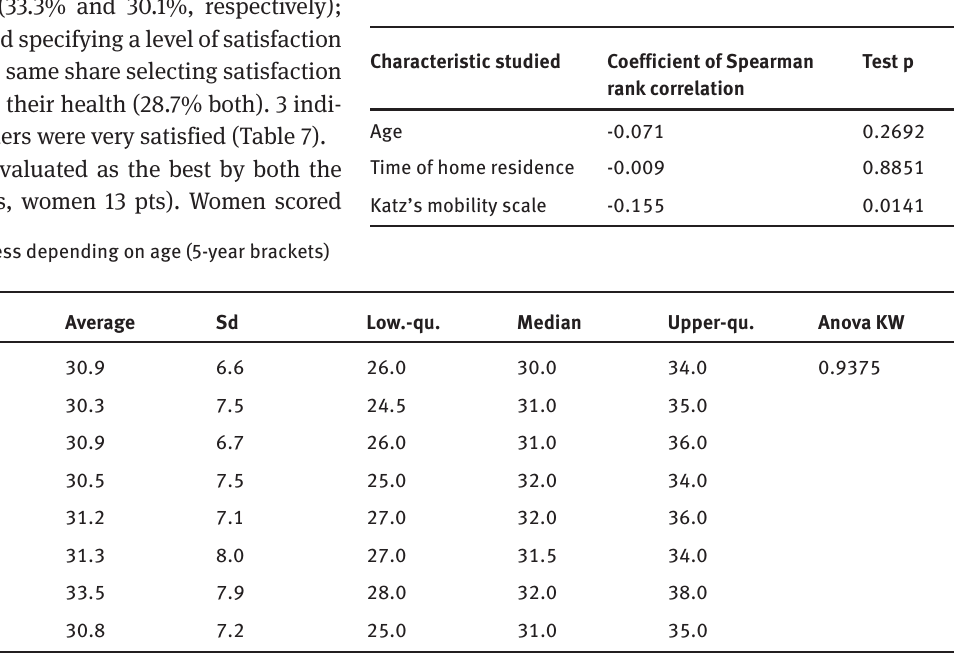
Table 4: Dependence between DJG loneliness scale and age, dura- tion of residence at nursing home, and